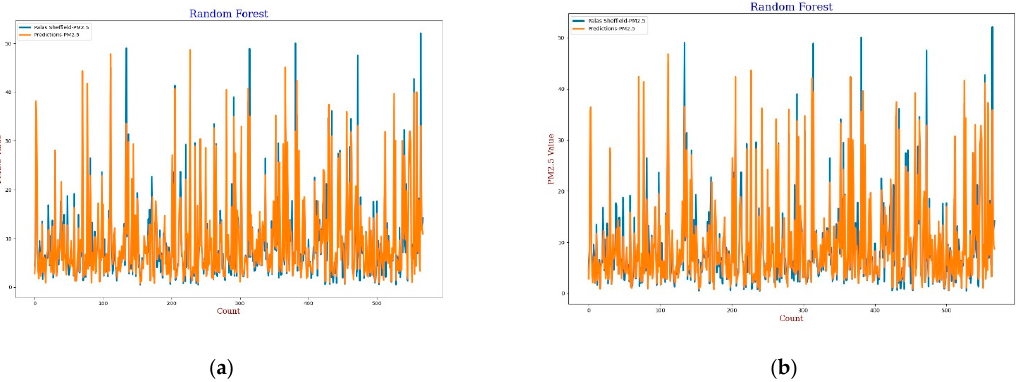
Figure 17. ( a ) RF calibration plot for PM 2.5 using AH . Blue colour represents the reference data and orange colour represents the calibrated data; ( b ) RF calibration plot for PM 2.5 using RH . Blue colour represents the reference data and orange colour represents the calibrated data.